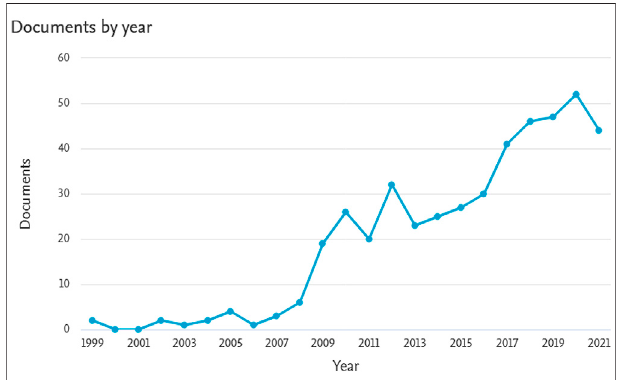
FIGURE 1 | Number of documents by year.